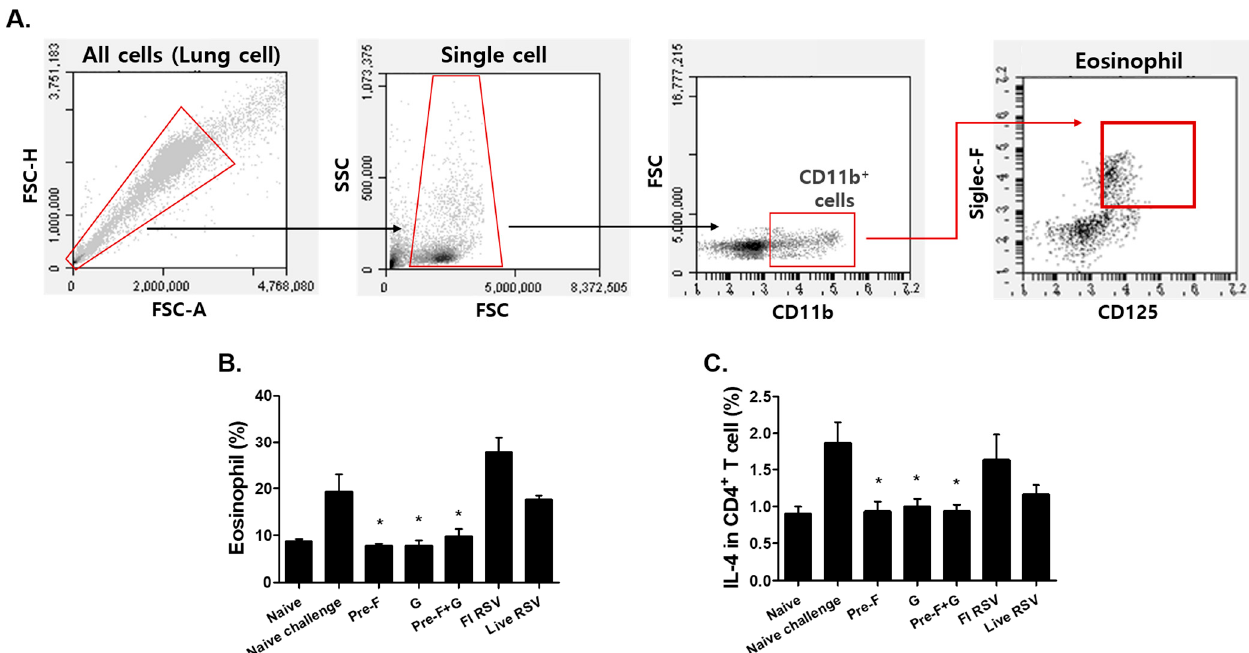
Figure 4. Eosinophil and IL-4 producing CD4 + T cell counts. To isolate the eosinophil and IL-4-pro- ducing CD4 + T cell phenotypes in the lung, lung cells were stained with fluorescent markers (CD11b, CD125, Siglec-F, CD3, CD4, and IL-4) and analyzed by BD Accuri C6 software ( A , B , C ). VLP-im- munized groups showed significantly lower levels of eosinophil compared to naïve challenge (( B ), * p < 0.05). A significantly lower level of IL-4-producing CD4 + T cells was observed in VLP-immun- ized mice than naïve challenged mice (( C ), * p < 0.05).